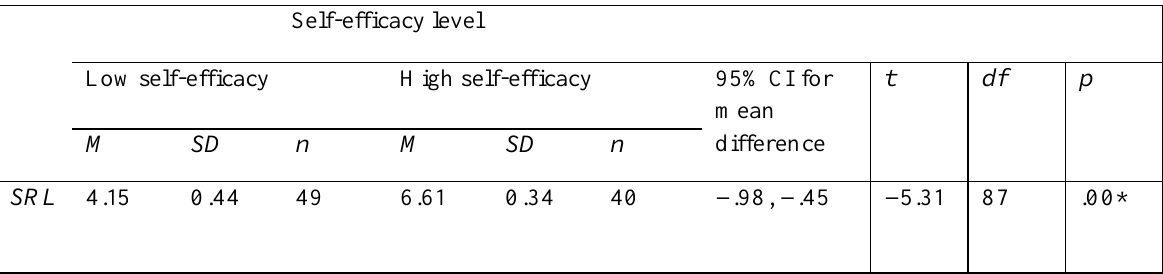
Results of Independent Sample t-Test and Descriptive Statistics for Self-Regulated Learning Scores by Self-Efficacy Levels